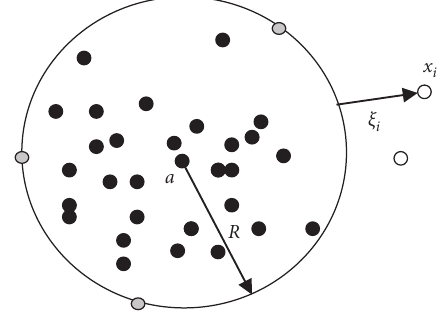
Figure 2: Suprasphere of support vector data